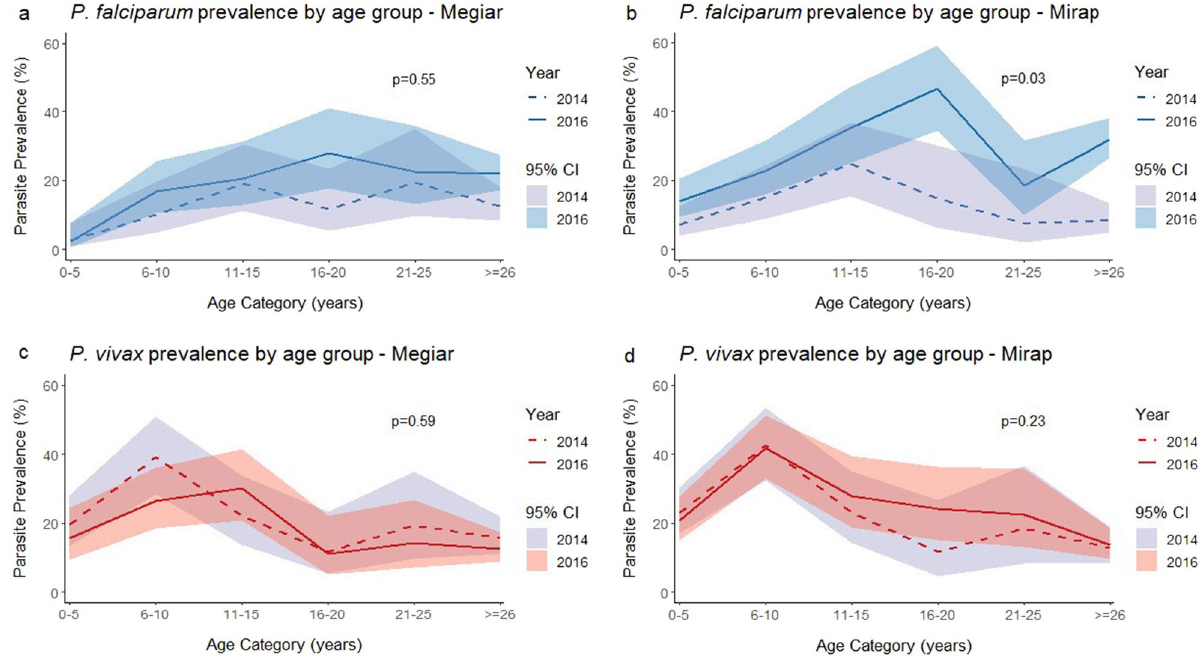
Figure 2. Malaria infection prevalence by age group and year for P. falciparum in Megiar ( a ), P. falciparum in Mirap ( b ), P. vivax in Megiar ( c ), and P. vivax in Mirap ( d ). 95% confidence interval (CI) denoted by coloured bands. P-values denote the test of independence of prevalence trend by age groups between 2014 and 2016 in each